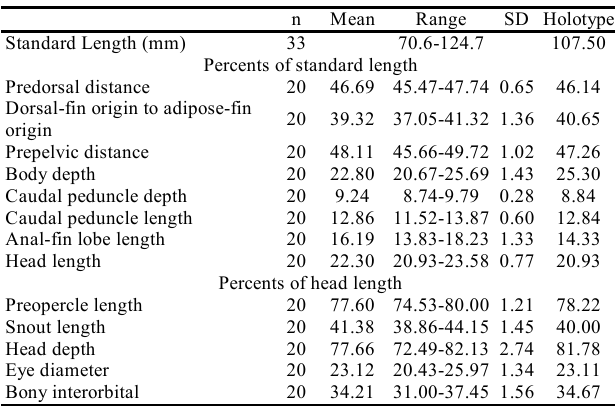
Table 1. Morphometric data for Leporinus guttatus . SD = Standard Deviation.